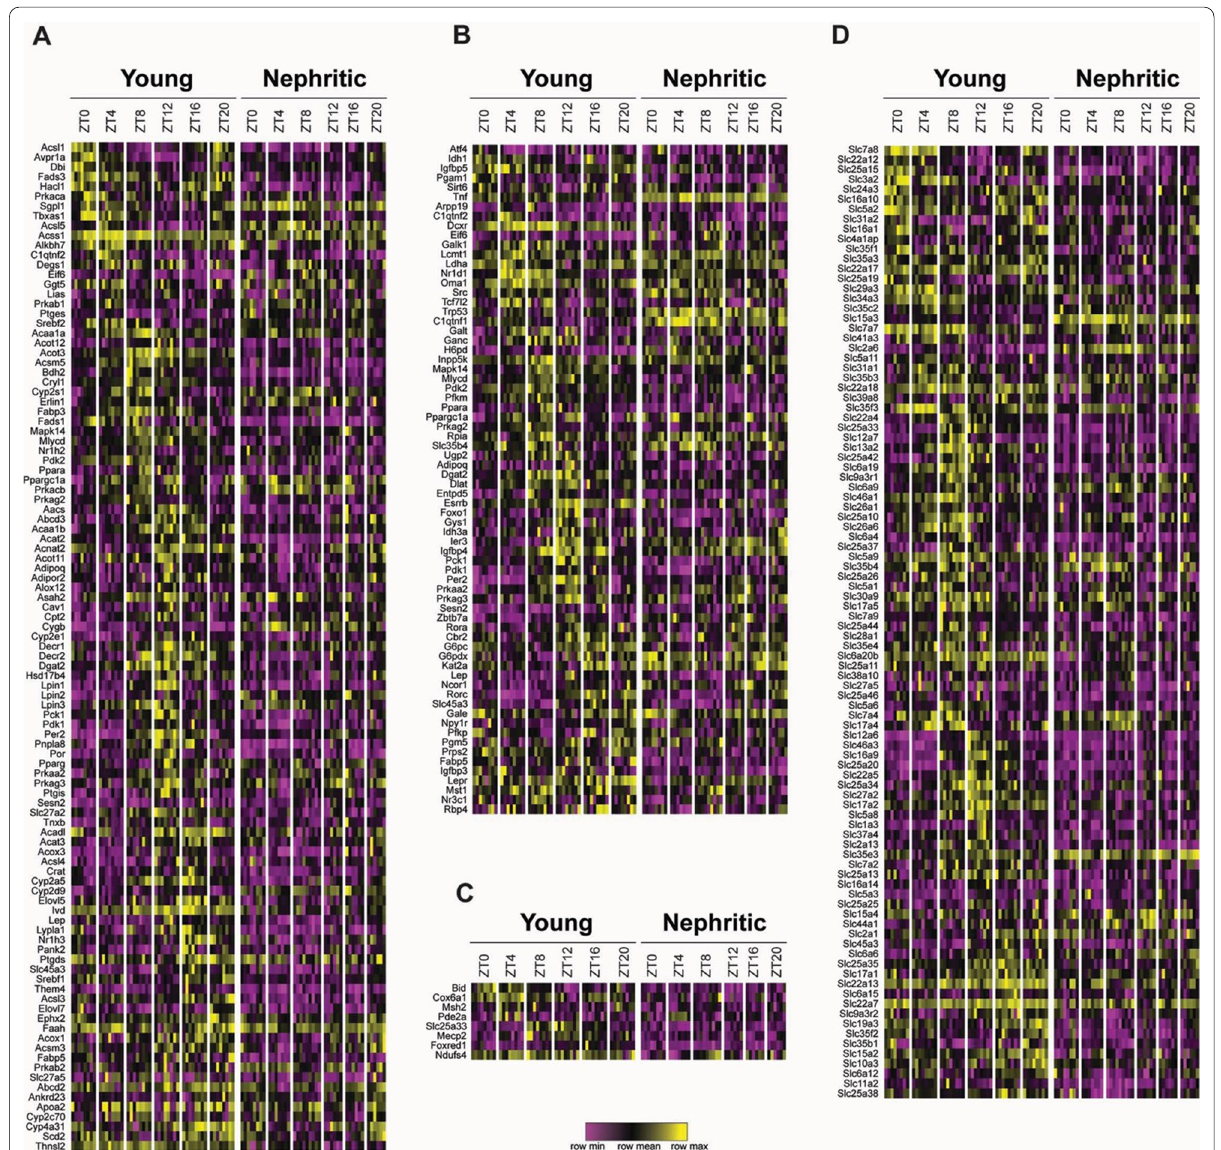
Fig. 3 Heatmaps of genes involved in metabolic pathways in young and nephritic mice. A Fatty acid metabolism; B glycolysis; C Mitochondrial oxidation and respiration; D Slc family of transporters. Samples are the same as those shown in Additional file 1: Figure